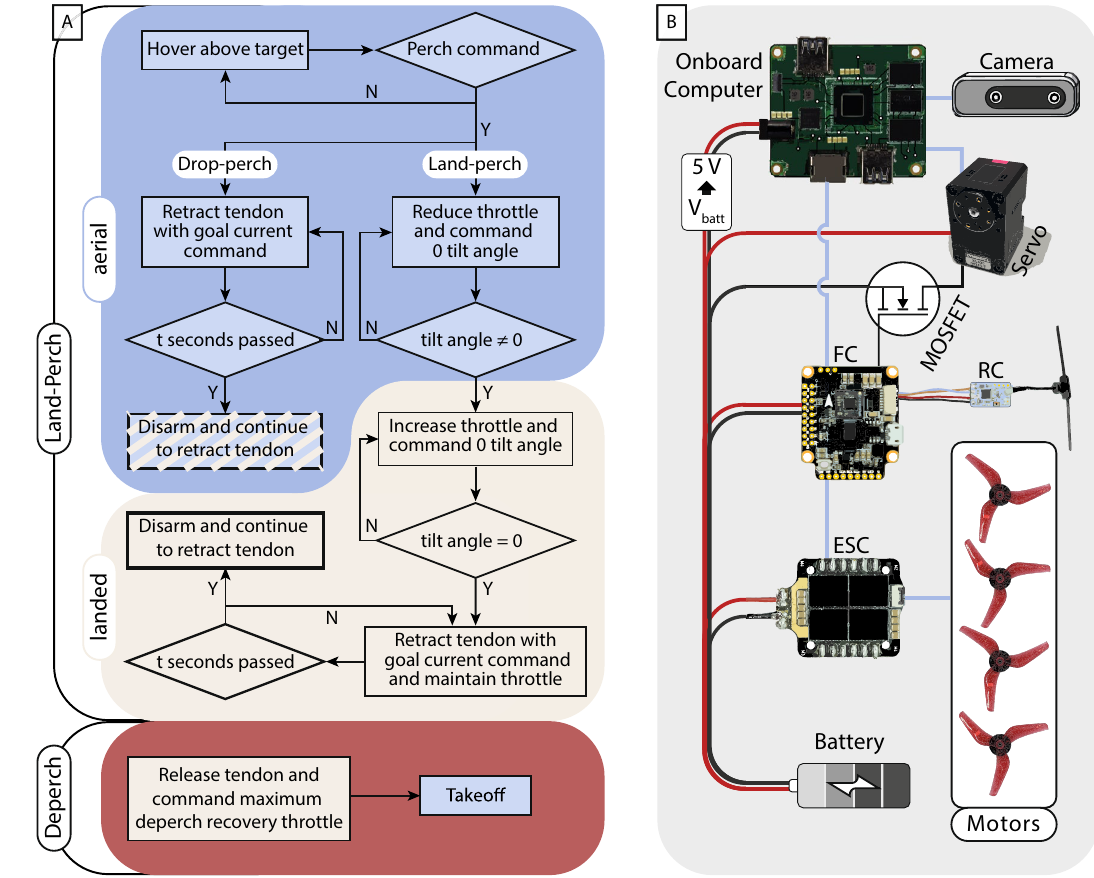
Figure 7. The control flow chart and electronics system. ( A ) The finite state machine of the land-perch procedure, the drop-perch controller, and the deperch process. ( B ) The electronics architecture of the robot with an additional N-channel MOSFET to switch on and off the